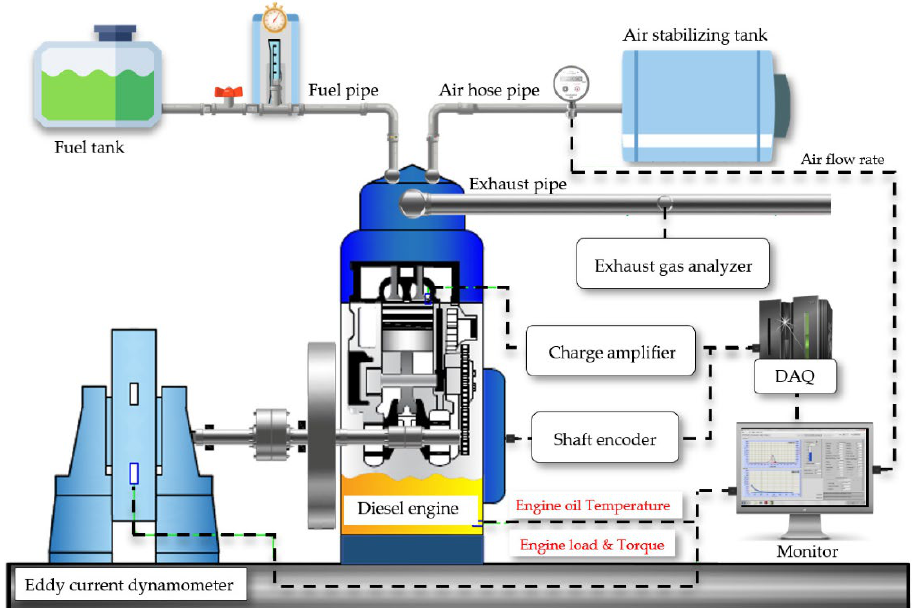
Figure 2. Schematic illustration of the experimental setup [49]. Table 5. Technical details of the test rig.